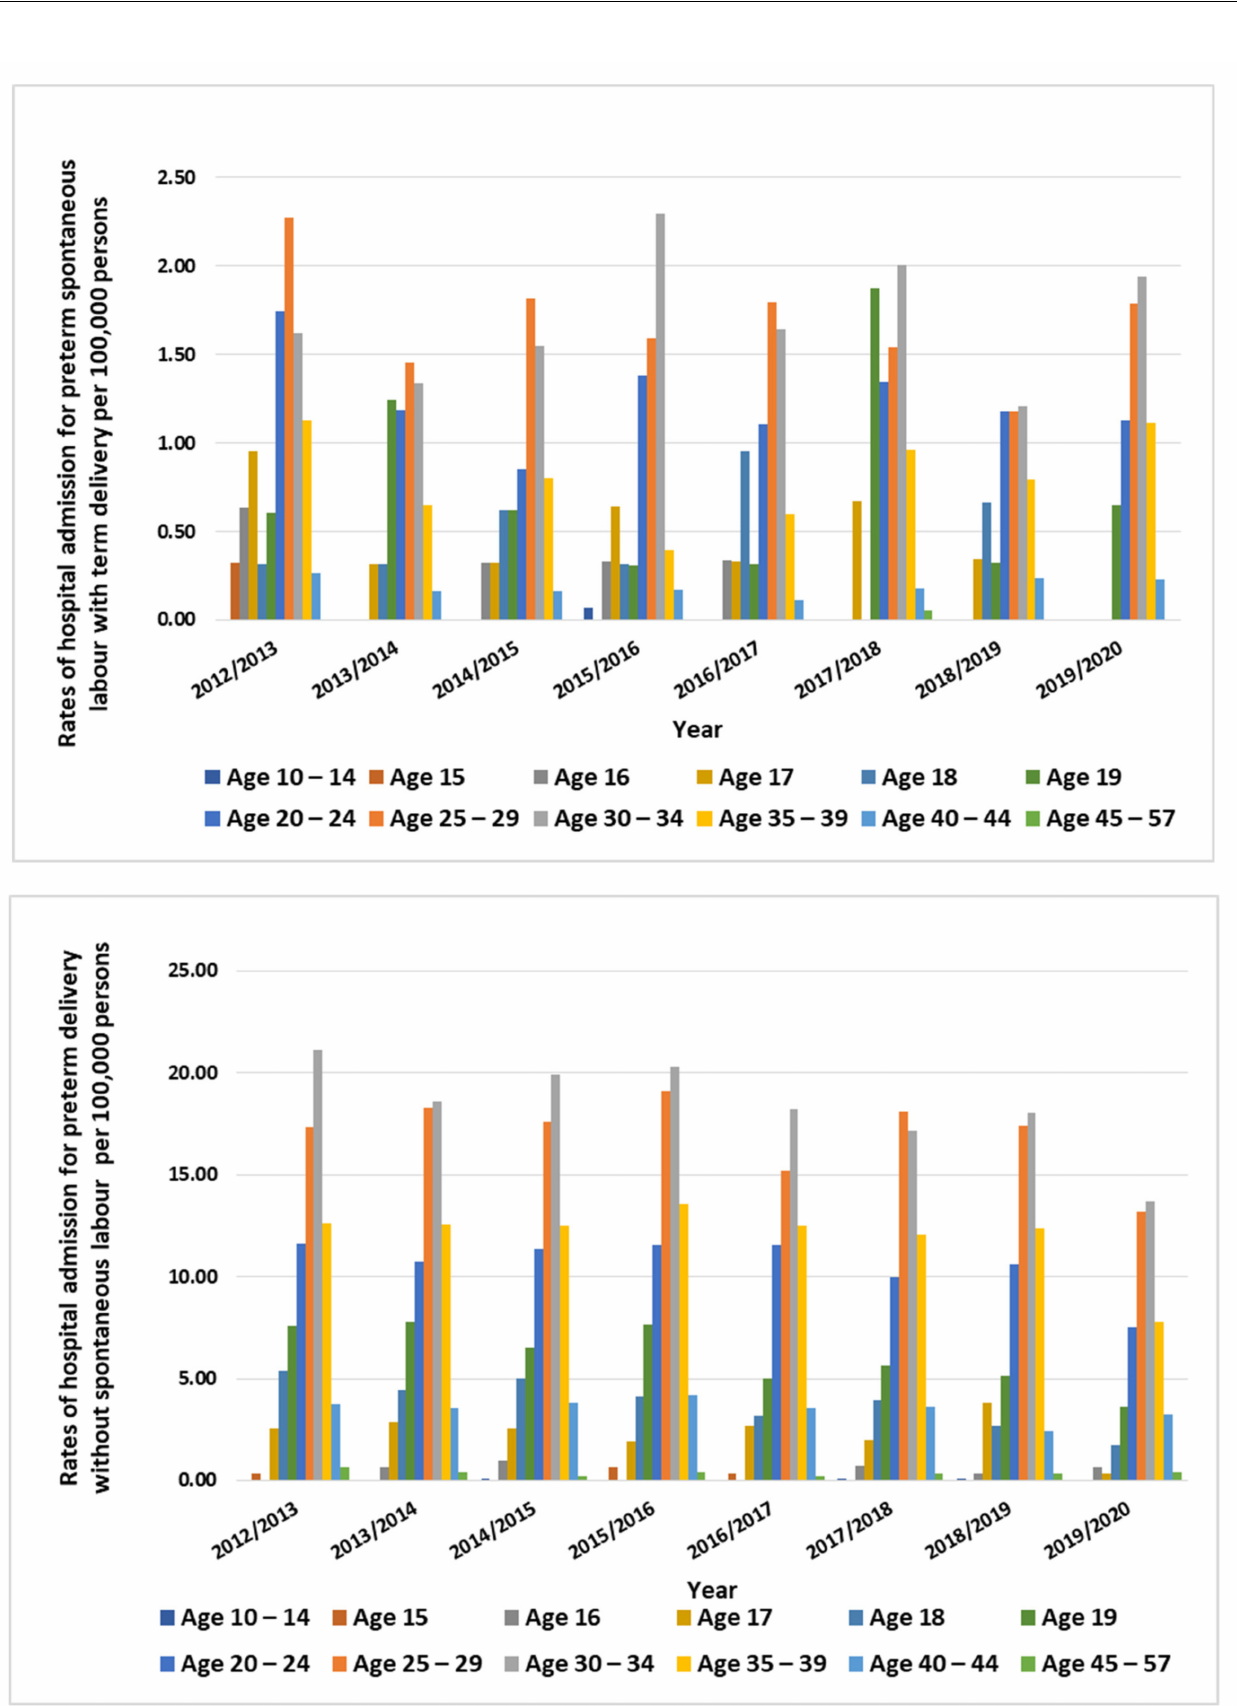
Figure 3. Hospital admission rates stratified by age